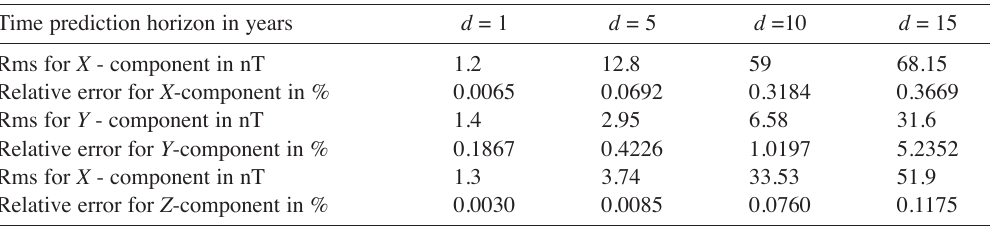
Fig. 6a-c. Predicted values of a) X, b) Y and c) Z Component by NN for 1956–1970 period and the respective values calculated by Gufm1 model (First way of data input).